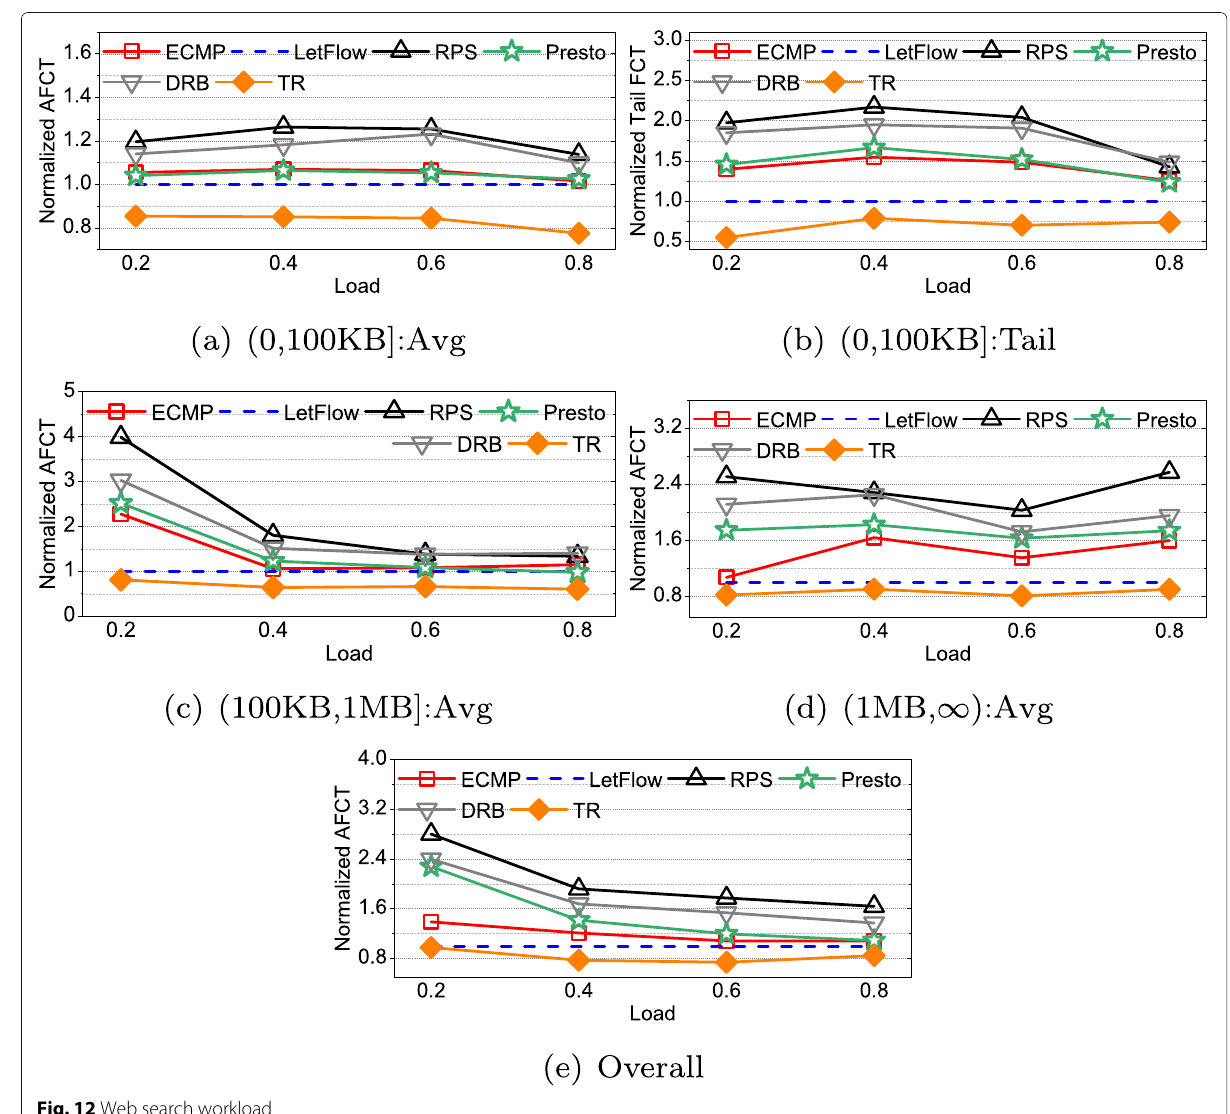
Fig. 12 Web search